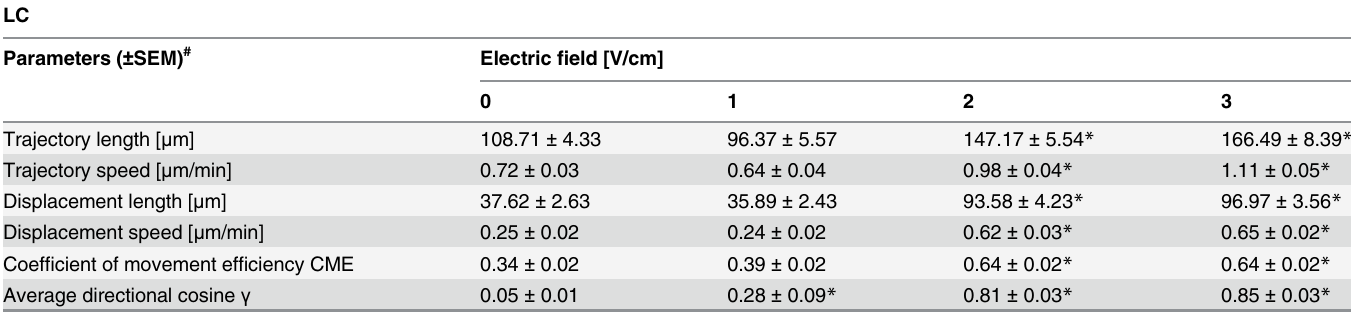
Table 3. Parameters characterizing LC cell migration under isotropic conditions and after the application of an electric field.